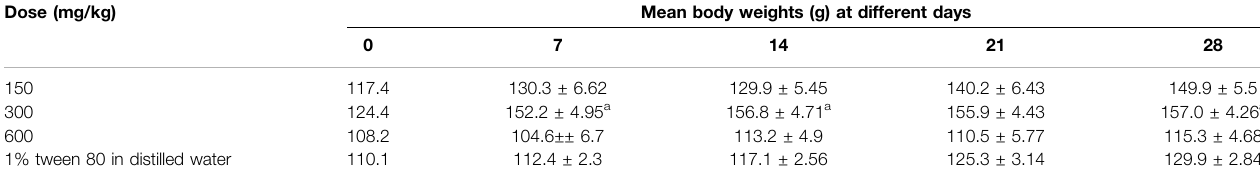
TABLE 1 | Mean body weights of the rats at different days of the experiment. Dose (mg/kg) Mean body weights (g) at different days